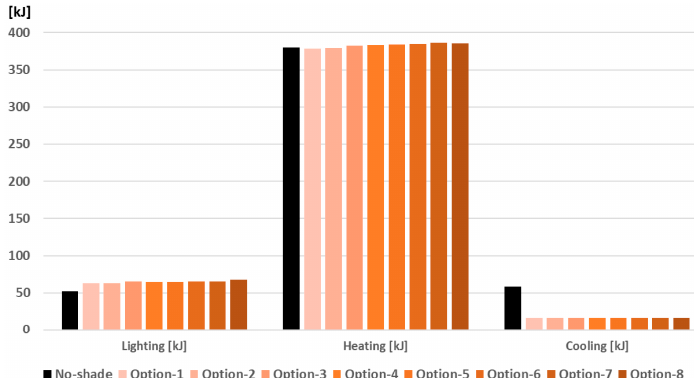
Figure 13. Monthly analysis of di ff erent options’ e ff ect on average DGP ( a ) and mean UDI-autono- mous range ( b ).